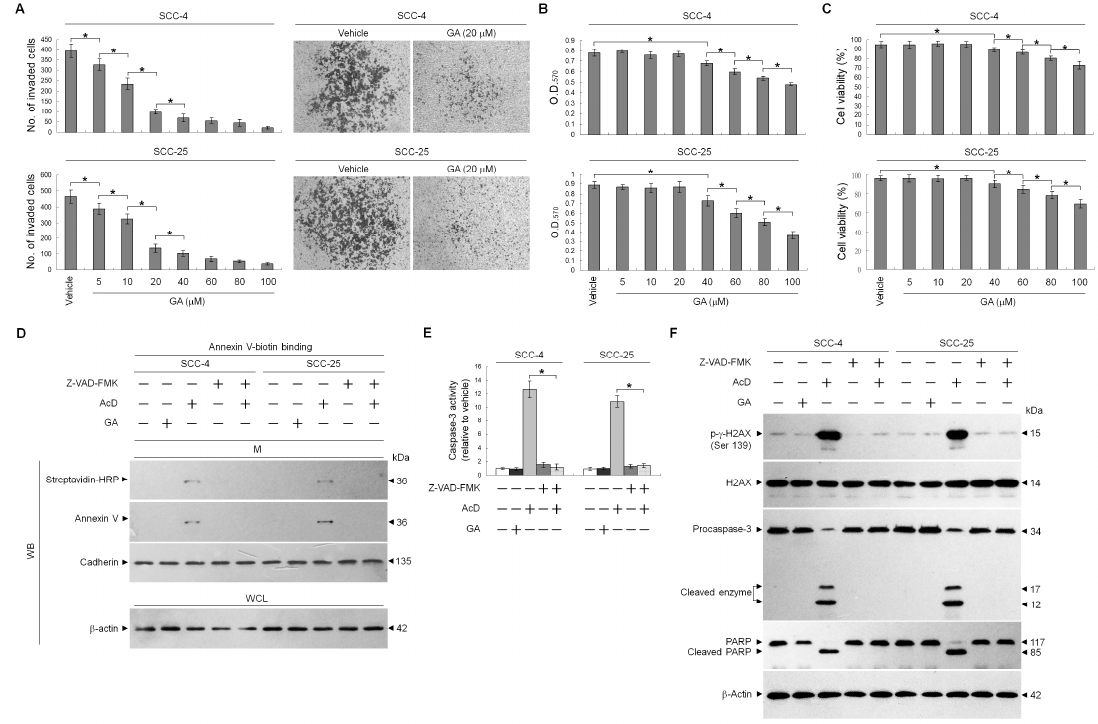
Figure 1. Gallic acid (GA) inhibits the invasive activity of human tongue squamous carcinoma (TSC) cells. ( A – C ) The e ff ect of GA on TSC cell invasion. TSC cells were treated with vehicle ( − ) or the indicated concentrations of GA for 36 h. The number of invaded cells was assessed using the Matrigel invasion assay. Cell growth and viability were determined by the 3-(4,5-dimethylthiazol-2-yl)-2, 5-diphenyltetrazolium bromide (MTT) assay and flow cytometric analysis of propidium iodide (PI) uptake, respectively. The values are presented as the means ± standard error (S.E.M.) of three independent experiments. * p < 0.05: significantly di ff erent from vehicle ( − ) or GA-treated cells. ( D , E ) The e ff ect of GA on the induction of cancer cell apoptosis. After a 36 h treatment with vehicle, GA (20 µ M), actinomycin D (ActD) (10 µ M), or ActD and Ac-DEVD-CMK (8 µ M), the caspase-3 activity was determined using flow cytometry. The values are presented as the S.E.M. of three independent experiments. * p < 0.05: significantly di ff erent from ActD-treated cells. Annexin V-biotinylated vehicle- or GA-treated cells were fractionated by subcellular fractionation centrifugation to isolate the plasma membrane (M) fraction. The level of the indicated proteins in the lysates of vehicle- or GA-treated whole cell (WC) and M fraction were determined by Western blot analysis using streptavidin-HRP and specific antibody to Annexin V. Antibody against cadherin was used as internal controls for the plasma membrane. β -Actin was used as an internal control for sample loading. ( F ) The levels of phosphorylated histone H2A.X (p- γ -H2AX), H2AX, poly (ADP-ribose) polymerase (PARP), and caspase-3 in the WCL were determined by Western blot analysis with specific antibodies. β -Actin was used as an internal control for sample